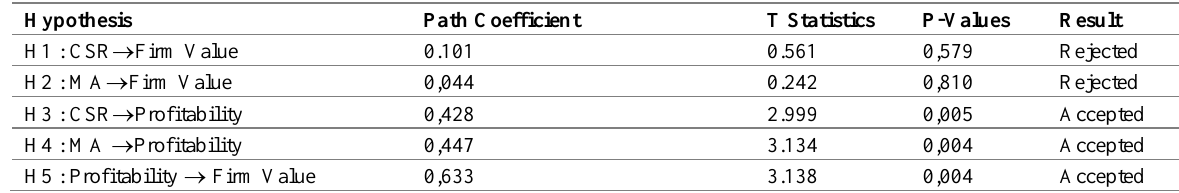
Table 2: Direct Hypothesis Testing Results